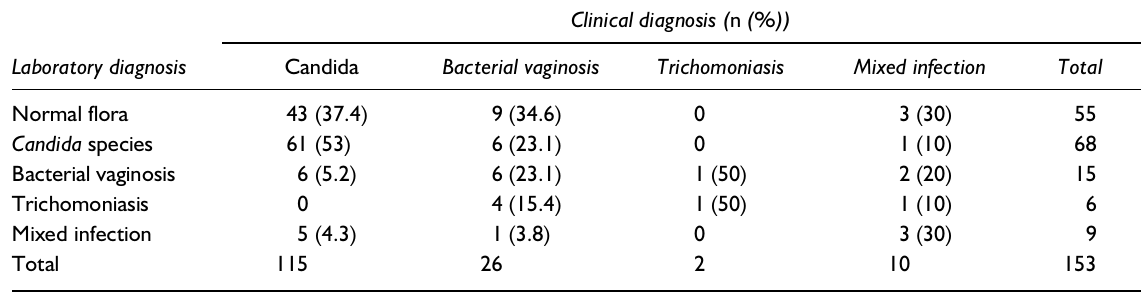
Table 2 Comparison of the clinical and laboratory diagnoses. k agreement = 18%; numbers in parentheses are percentages of cases in the same